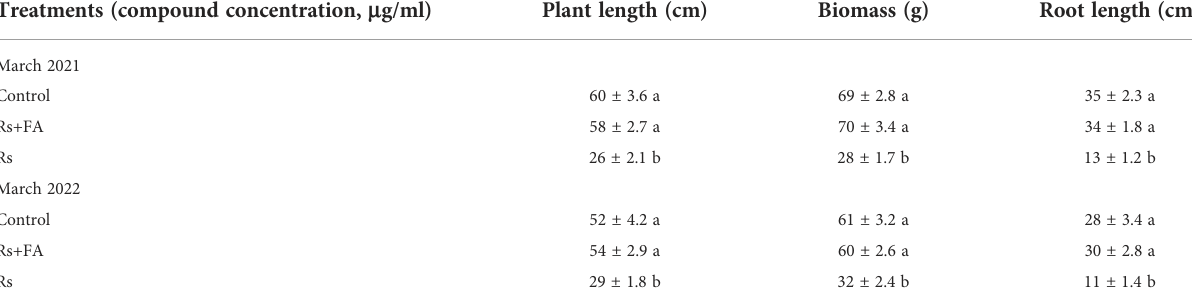
TABLE 2 Effect of different concentrations of FA on tomato plant growth inoculated with bacterial wilt pathogen in fi eld experiment. Treatments (compound concentration, m g/ml) Plant length (cm) Biomass (g) Root length